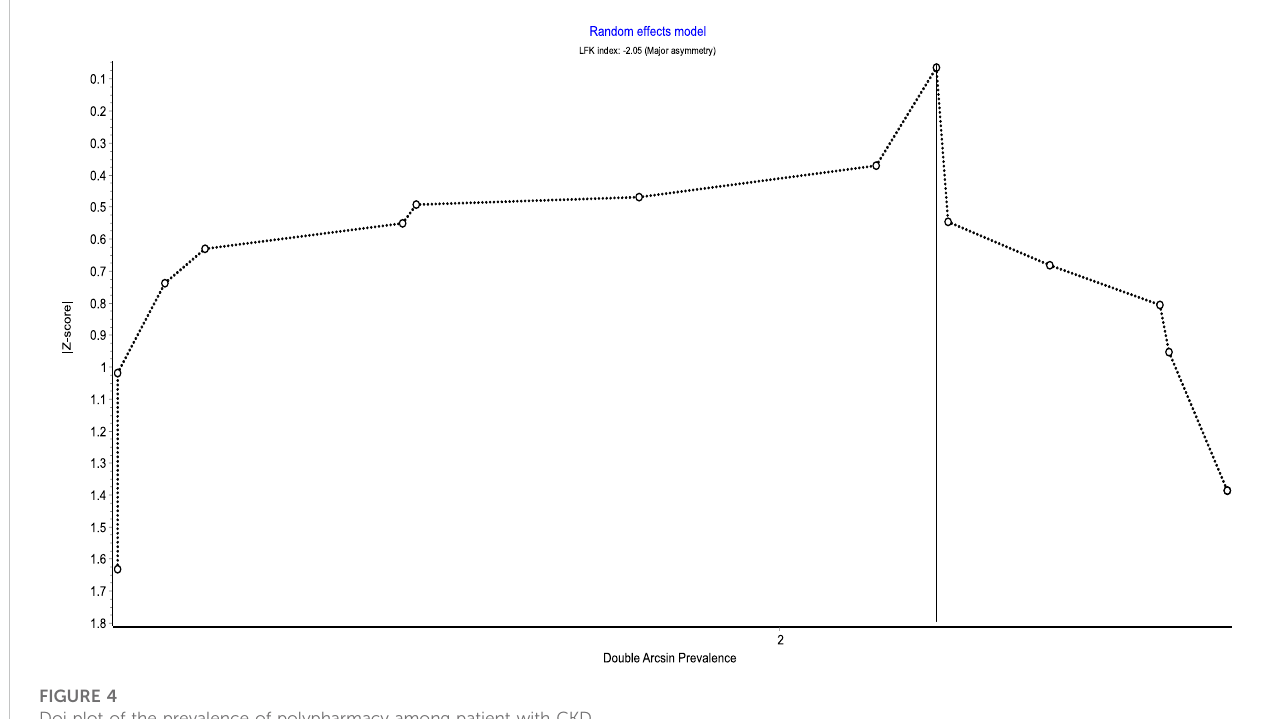
FIGURE 4 Doi plot of the prevalence of polypharmacy among patient with CKD.